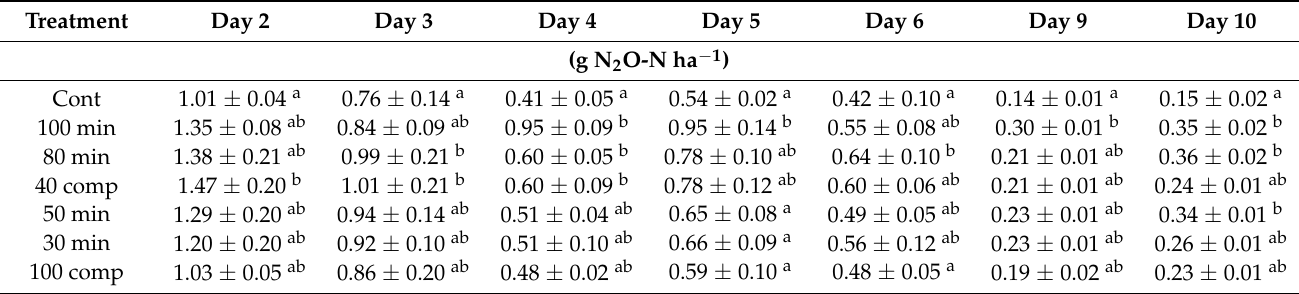
Table A1. Daily emission of nitrous oxide (N 2 O) at 40% water-filled pore space in different fertilizer treatments (incubation experiment). Only the days with significant differences between the treatments are listed.